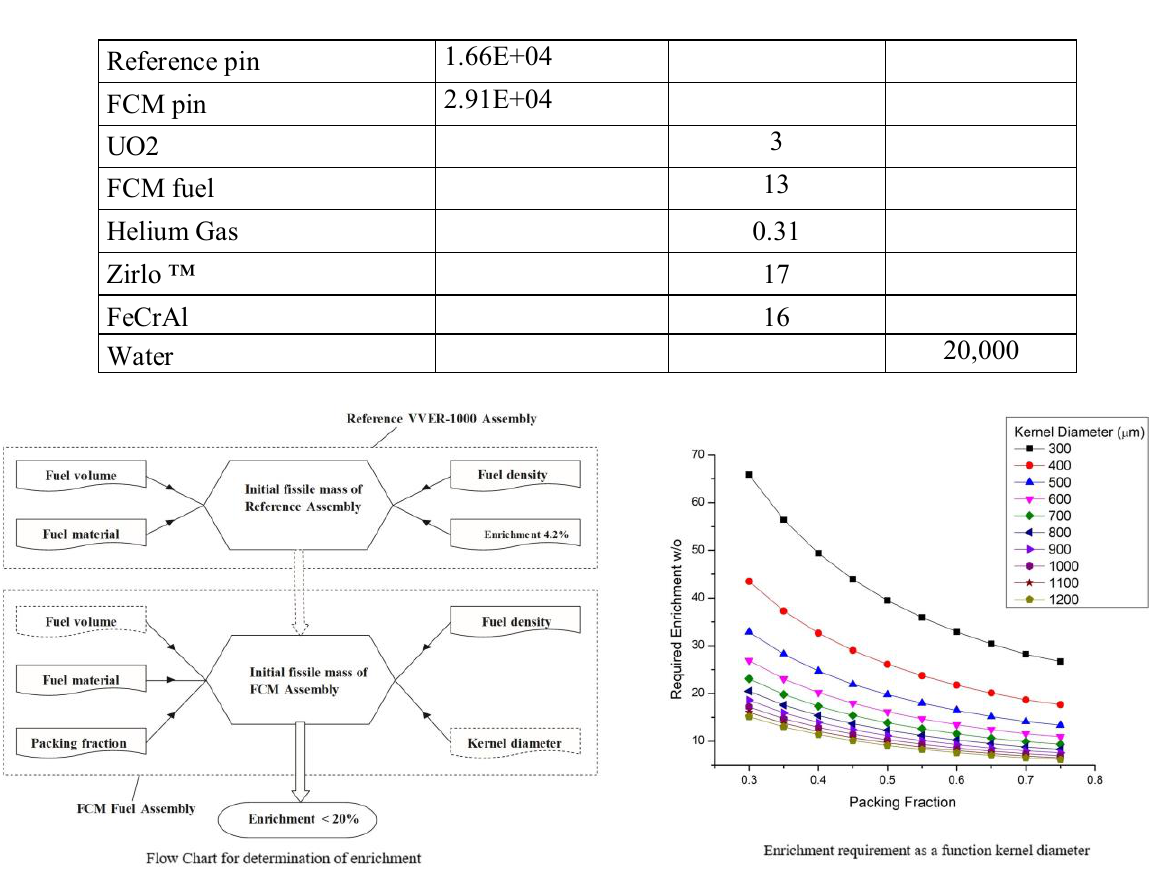
Figure 1. Enrichment determination.